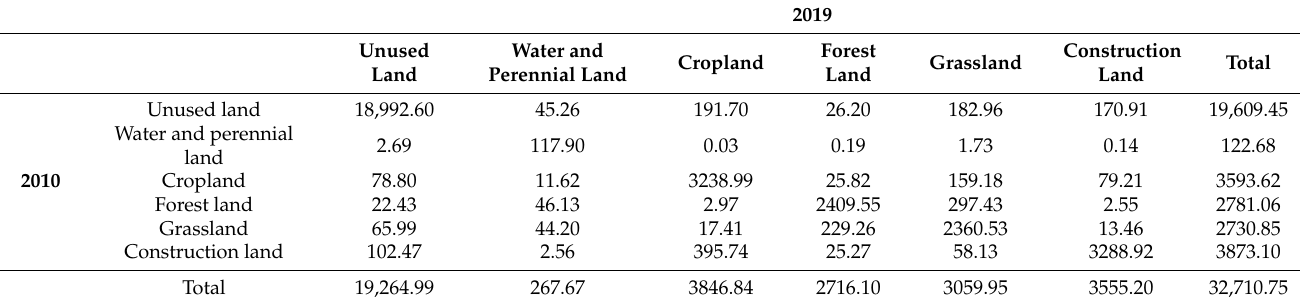
Table 6. Land use transition matrix between 2010 and 2019 (Unit) km 2